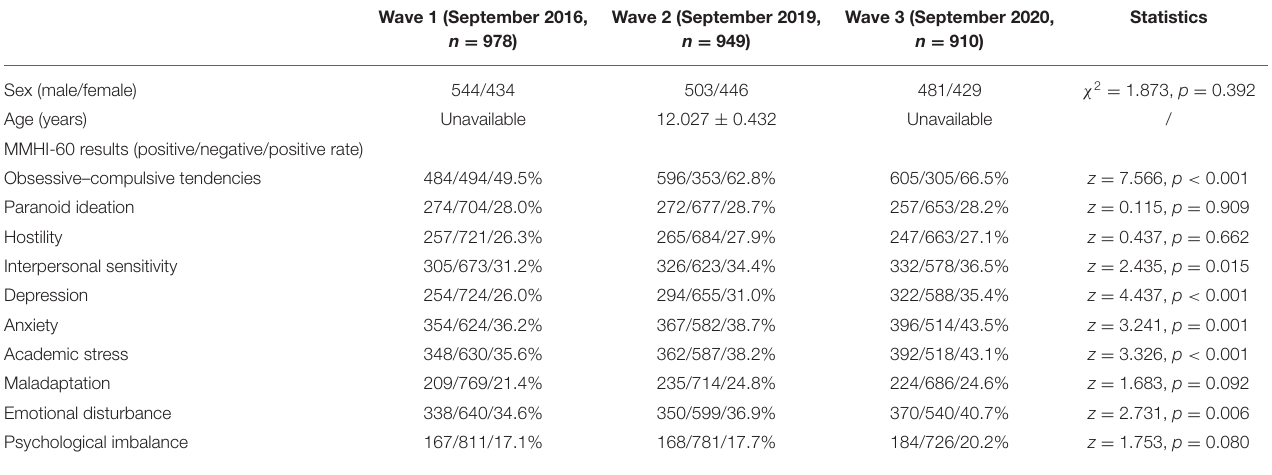
TABLE 1 | Sample characteristics of the participants surveyed in each